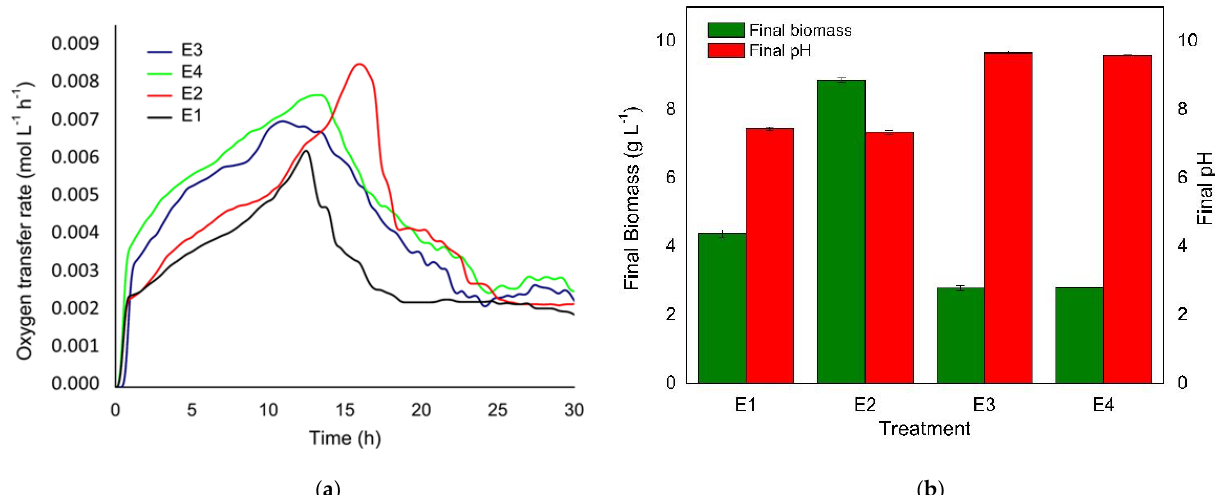
Figure 1. ( a ) Online measurement of the oxygen transfer rate (OTR) of C. sorokiniana heterotrophic cultures grown in TAP medium supplemented with different carbon sources (E1 and E2 with glucose, E3 and E4 with acetate and glucose). ( b ) Final biomass concentration and medium-pH reached for each treatment.